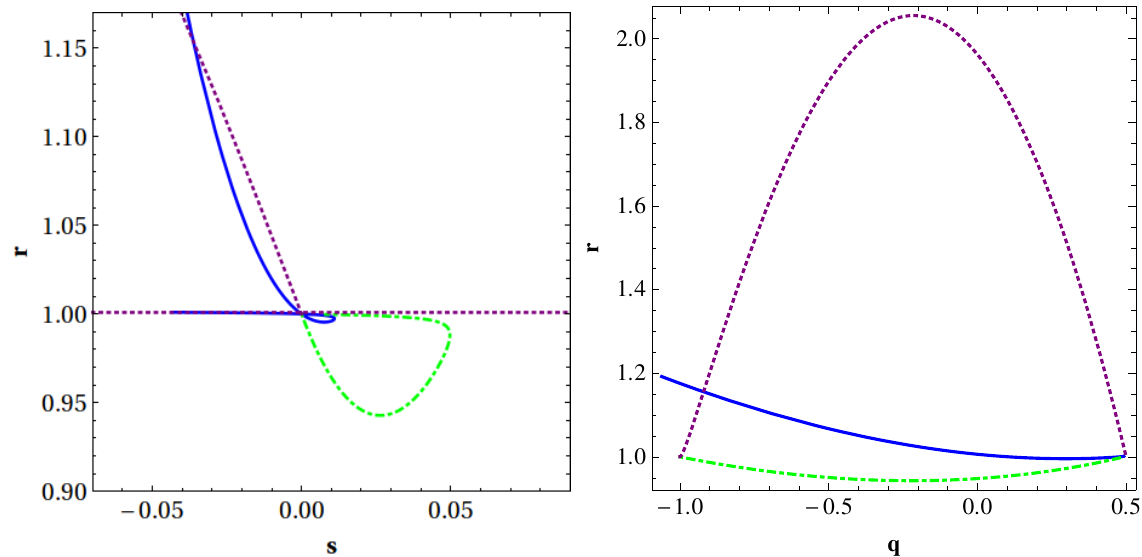
Figure 5. The time evolutions of the statefinder pair ( s , r ) ( left panel) and the pair ( q , r ) ( right panel) for different models are shown using the H ( z ) + BAO + CMB + BBN + SNIa (Pantheon) dataset. Here, the blue, green, and dotted (purple) curves are for the NGCG, GCG, and CG models,